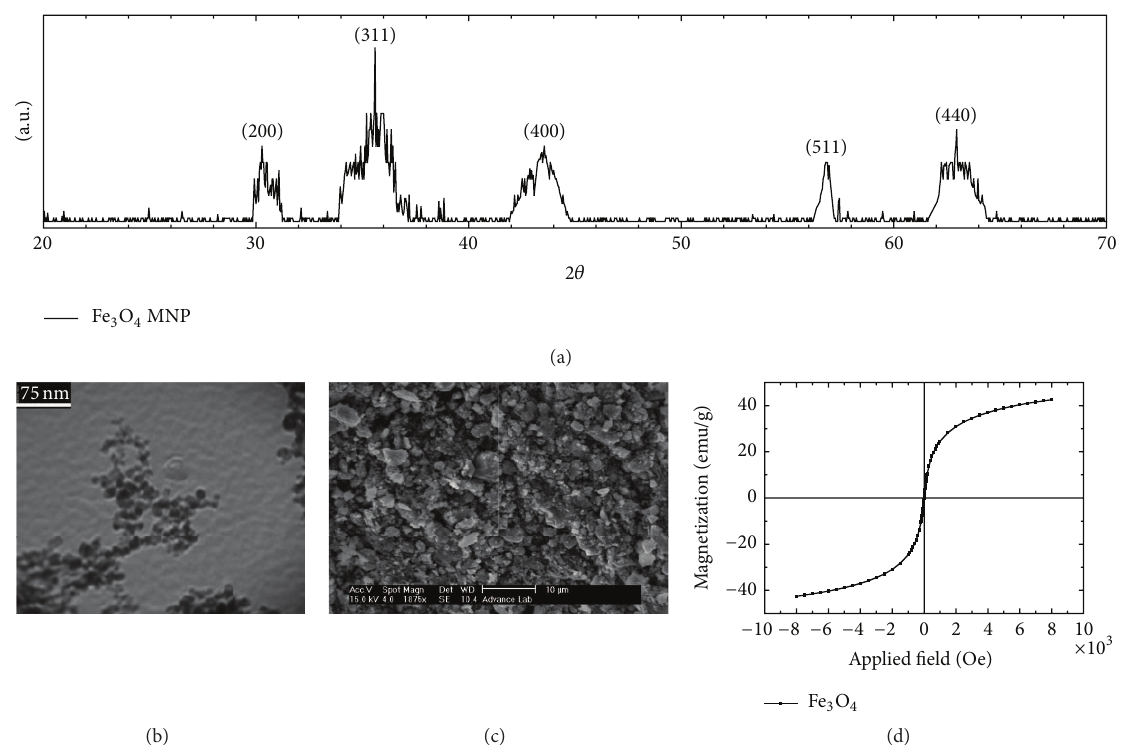
Figure 1: Typical (a) XRD, (b) TEM, (c) SEM image, and hysteresis loop pattern (d) of as-prepared magnetite nanoparticles (MNPs). The scale bar in TEM and SEM image is 75 nm and 10 𝜇 m,